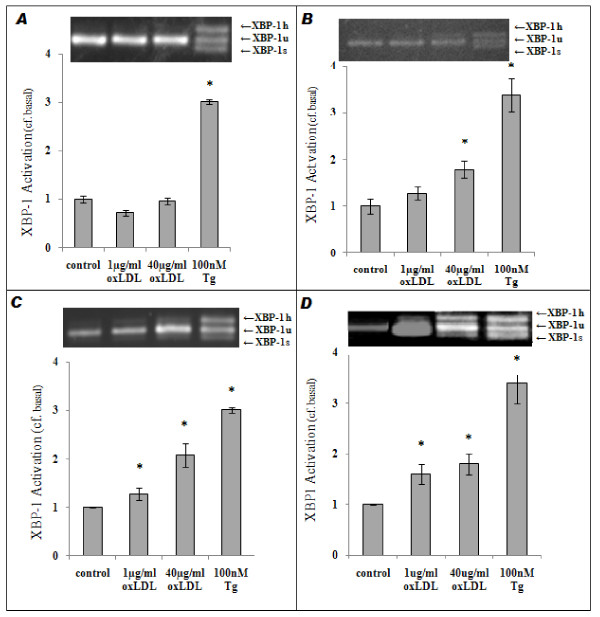
oxLDL-induced XBP-1 Activation in THP1-derived monocyte-macrophage cell-types. Representative images (insets) and densitometric summaries from agarose gels used to determine XBP-1 activation in THP1-Mon (A), THP1-M2Mon (B), dTHP1-MΦ (C) and dTHP1-M2MΦ (D) after treatment with oxLDL (1 μg/ml or 40 μg/ml; 24 h) or thapsigargin (100 nM; 24 h) as indicated. n ≥ 3 in all cases; P < 0.05 where indicated.